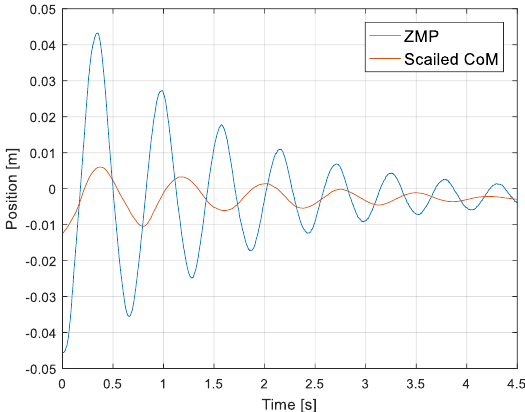
Figure 4. Oscillation of zero-moment point (ZMP) and center of mass (CoM) when a disturbance is applied to the robot. (For improved visualization, the CoM was increased three times).